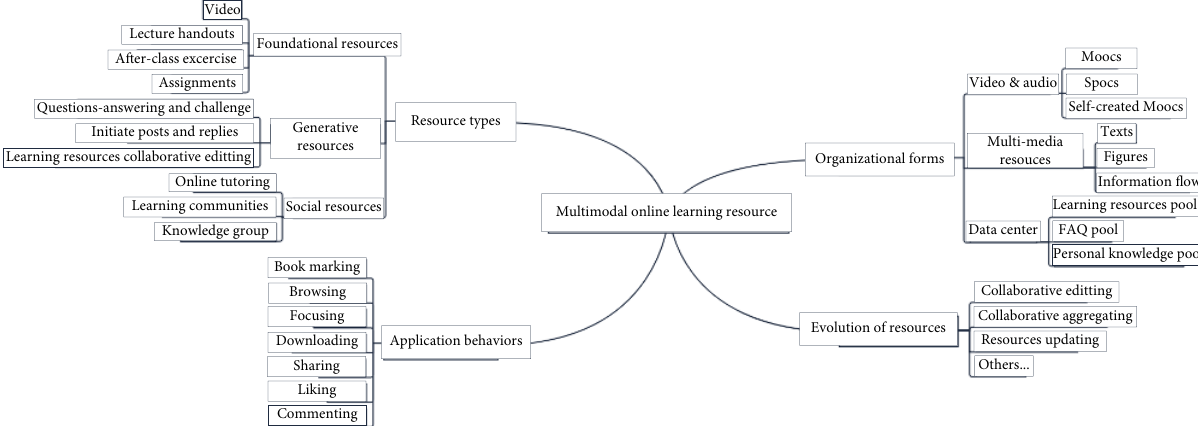
Fig. 1 Multimodal online learning resource